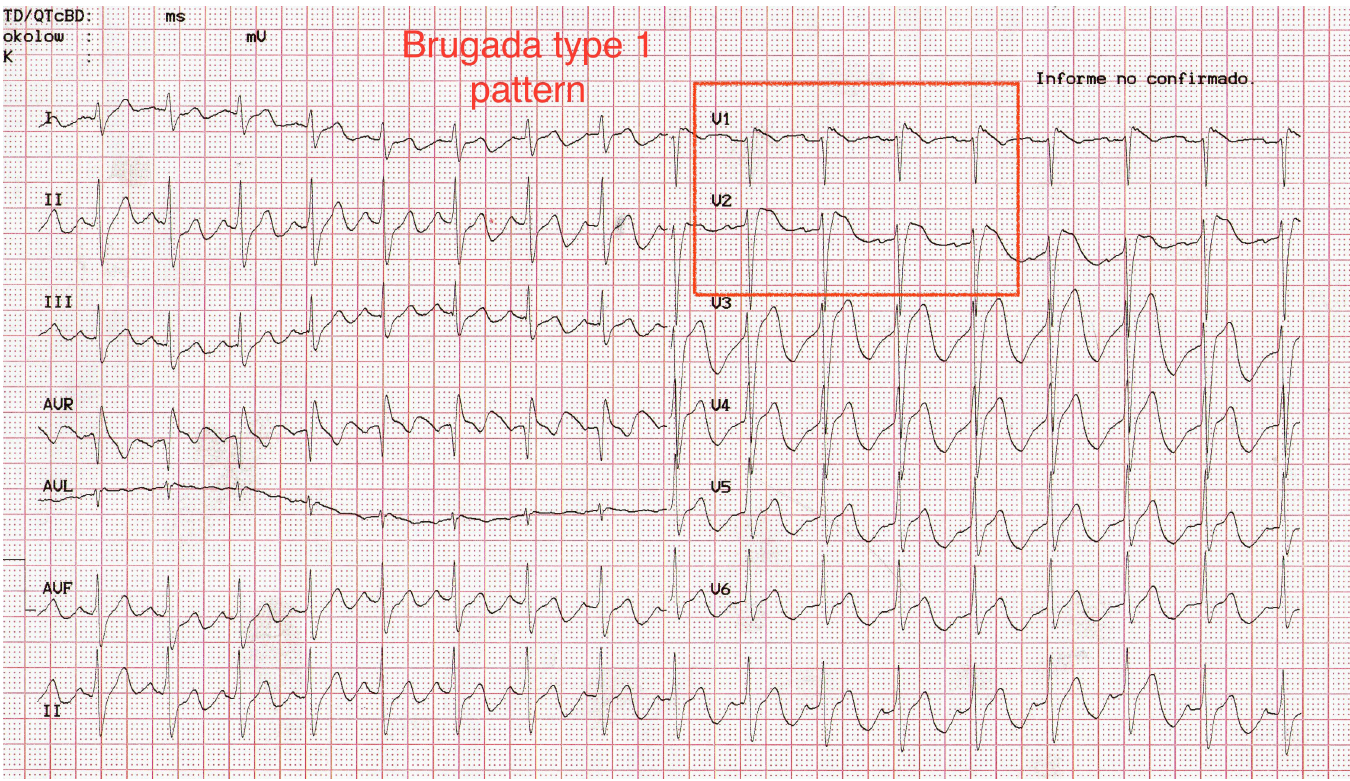
Figure 2. Twelve-lead electrocardiogram after successful defibrillation. Notice the Brugada type I pattern on the anterior